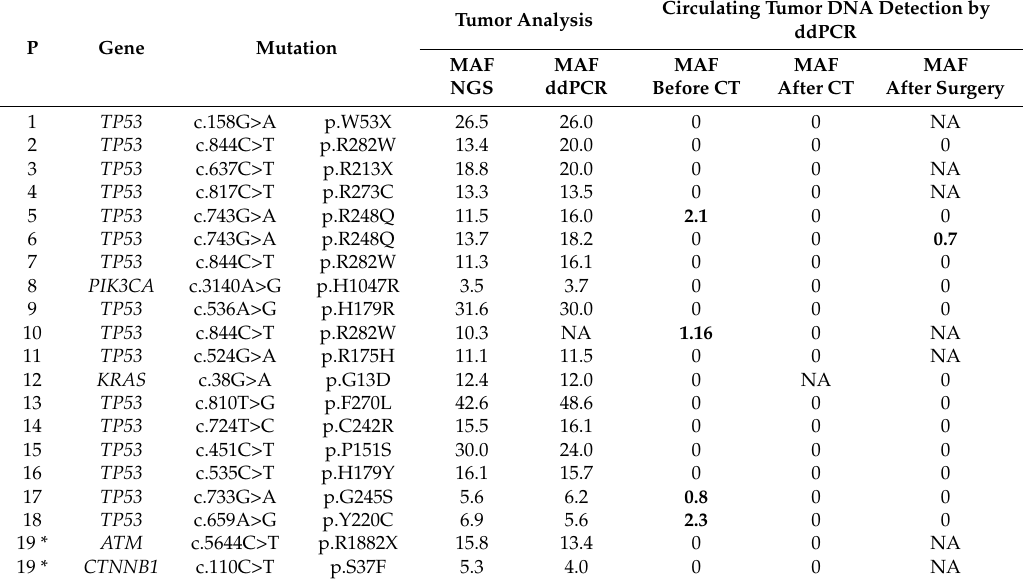
Table 2. List of trackable mutations, mutant allelic frequency (MAF) of trackable mutations in tissue and circulating tumor DNA according to time point.